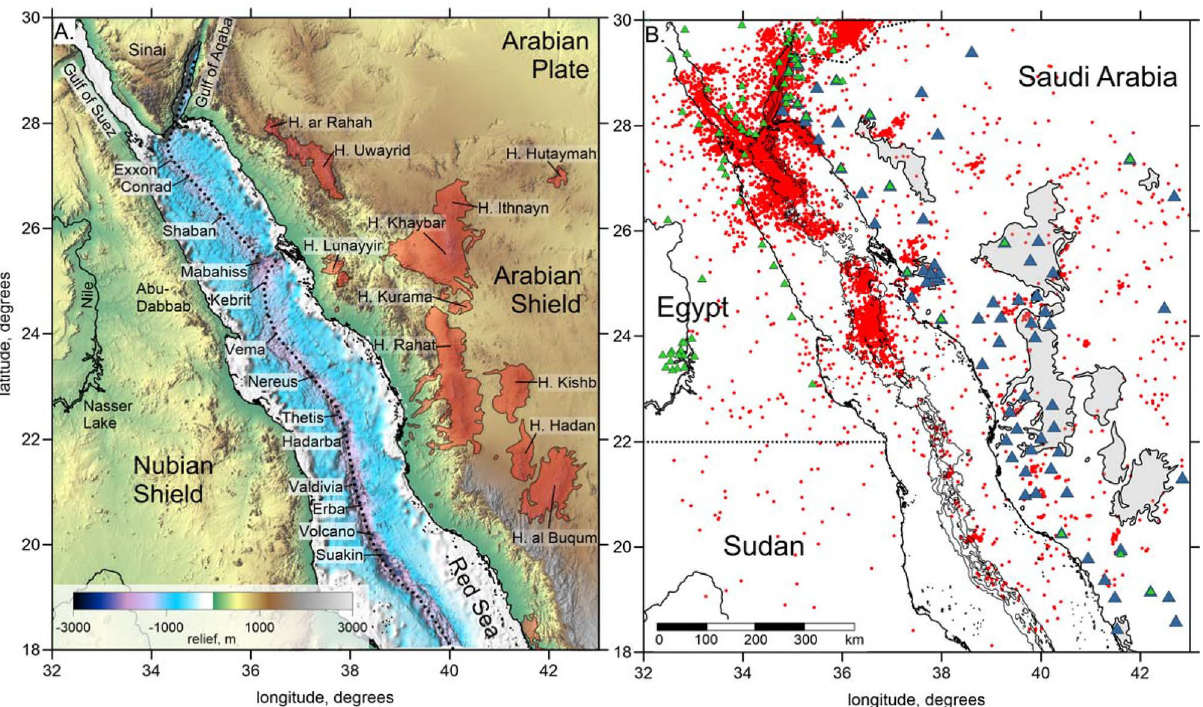
Figure 1. ( A ) Topography in the study area (http:// www. marine- geo. org). Red areas highlight the Harrats (Cenozoic basaltic fields); the dotted line indicates the axis of the Red Sea spreading/rifting. The names of the major deeps (depression points) in the Red Sea are shown. ( B ) Distribution of data used in this study: red points are events, blue triangles are Saudi Arabian stations, and green triangles are Egyptian stations and stations reporting to the ISC that were used in the previous tomographic studies 21,22 . Dotted lines indicate political boundaries. The images have been produced using the Surfer Golden Software 13 (https:// www. golde nsoft ware. com/ produ cts/